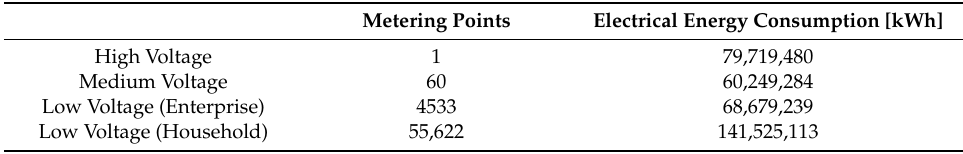
Table 2. Elektra Sisak area Characteristics [35].